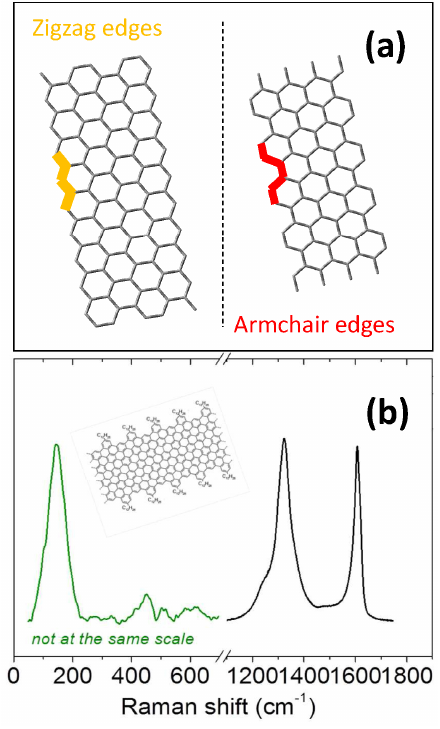
Figure 12. Nanoribbons. ( a ) Zigzag and armchair nanoribbons; ( b ) Typical spectra of a real nanoribbon, as studied by Casiraghi et al. [204].